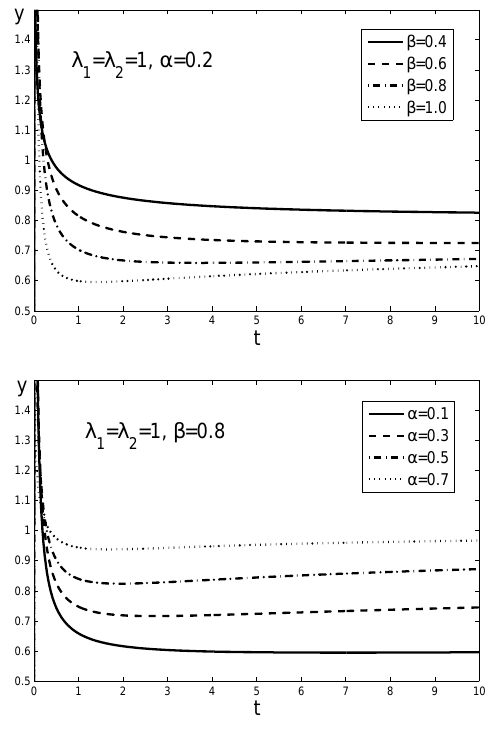
Fig. 3. Time profiles of the pressure gradient for α < β , A = 1 and λ 1 = λ 2 = 1 .